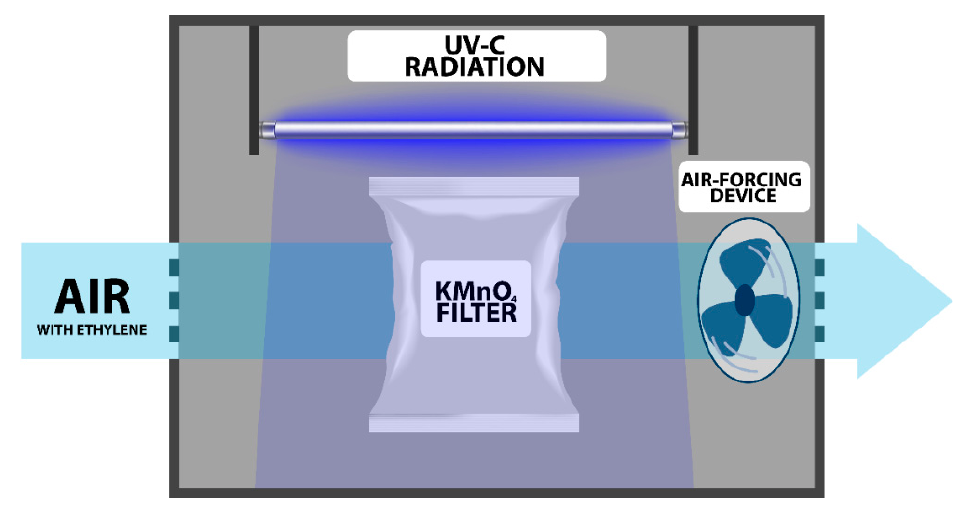
Figure 1. Ethylene scavenger diagram. Own source.